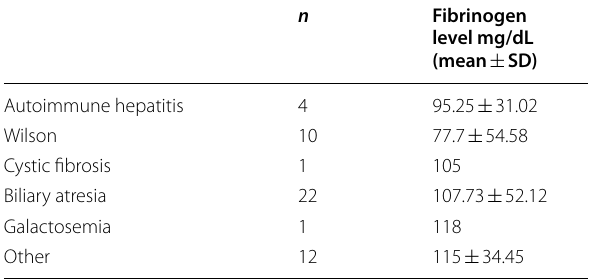
Table 4 The relationship between bleeding in children and their fibrinogen levels Fibrinogen classification